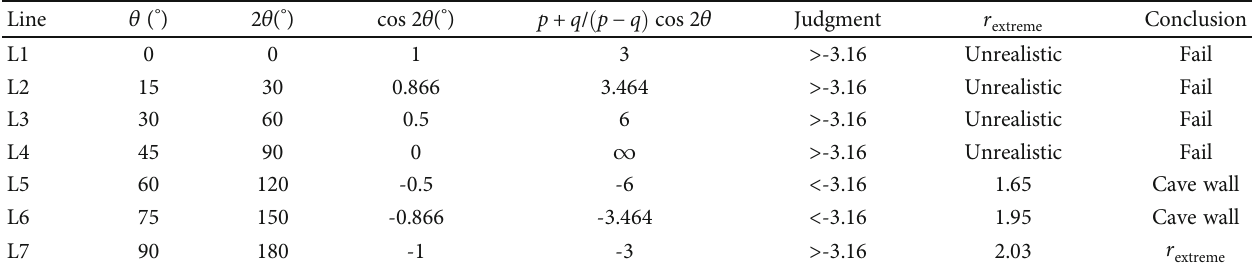
Table 6: The sensitivity of the displacement to the